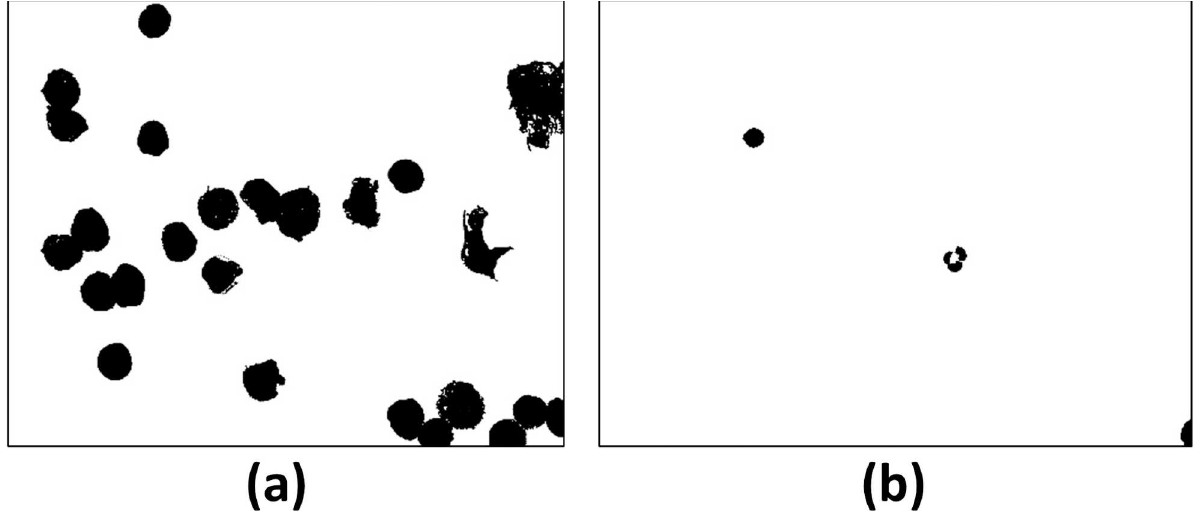
Fig 3. Ground truth of the images of Fig 1.